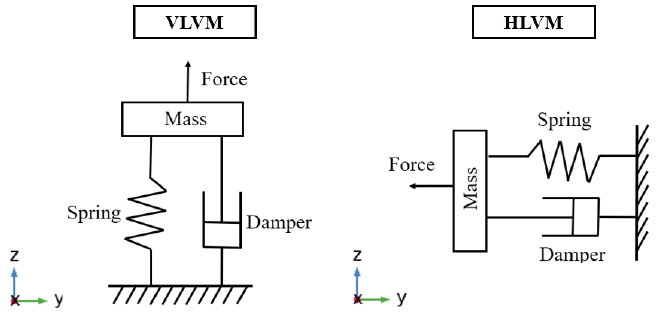
Figure 1. Comparison between VLVM and HLVM. VLVM vibrates along the height of the device (z-direction), which is the smallest dimension, while the HLVM vibrates along the length and width dimensions (x- or y- direction). There are many linear vibration motors that have been developed to obtain the best haptic feedback. However, due to the physical constraints of devices or touchscreens, the motor should be lightweight and